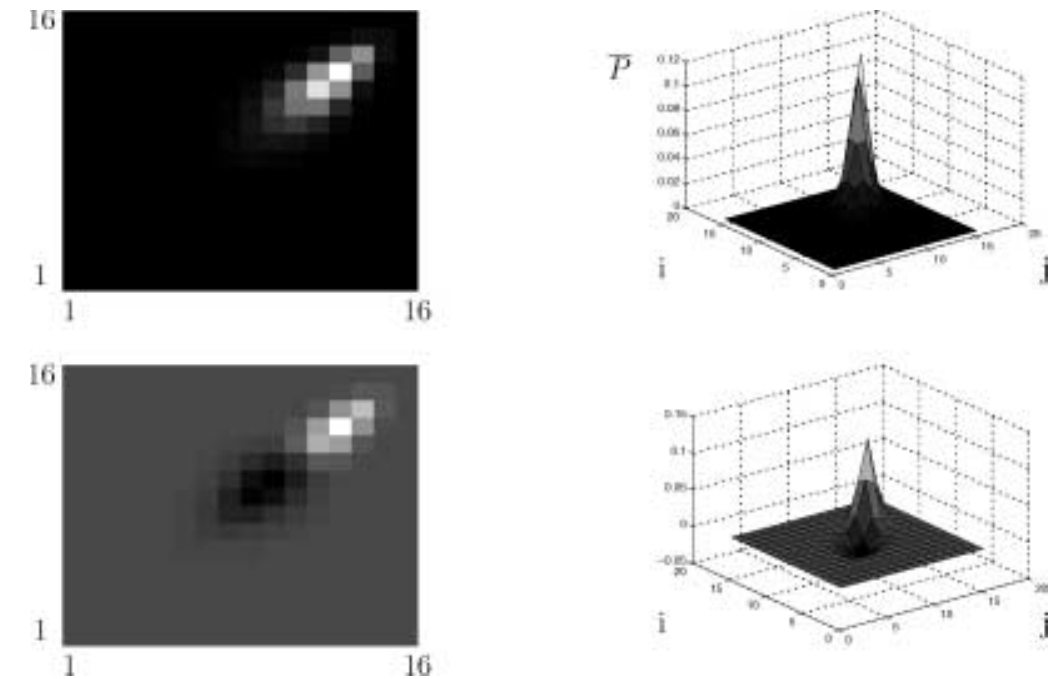
Fig. 4. Upper: The average normalized GLCM, P ( i , j | ω c ), computed from the peripheral part of all the monolayer nuclei images in the good prognosis group. Lower: The difference between the P ( i , j | ω c ) computed from the peripheral and central parts of monolayer nuclei images in the good prognosis group. The matrices are visualized both as gray-scale and surface